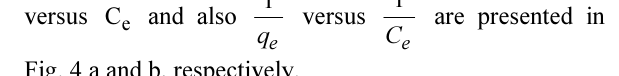
Fig. 2. A plot of ln (1– q / q e) vs. time according to the pseudo- first order adsorption kinetics